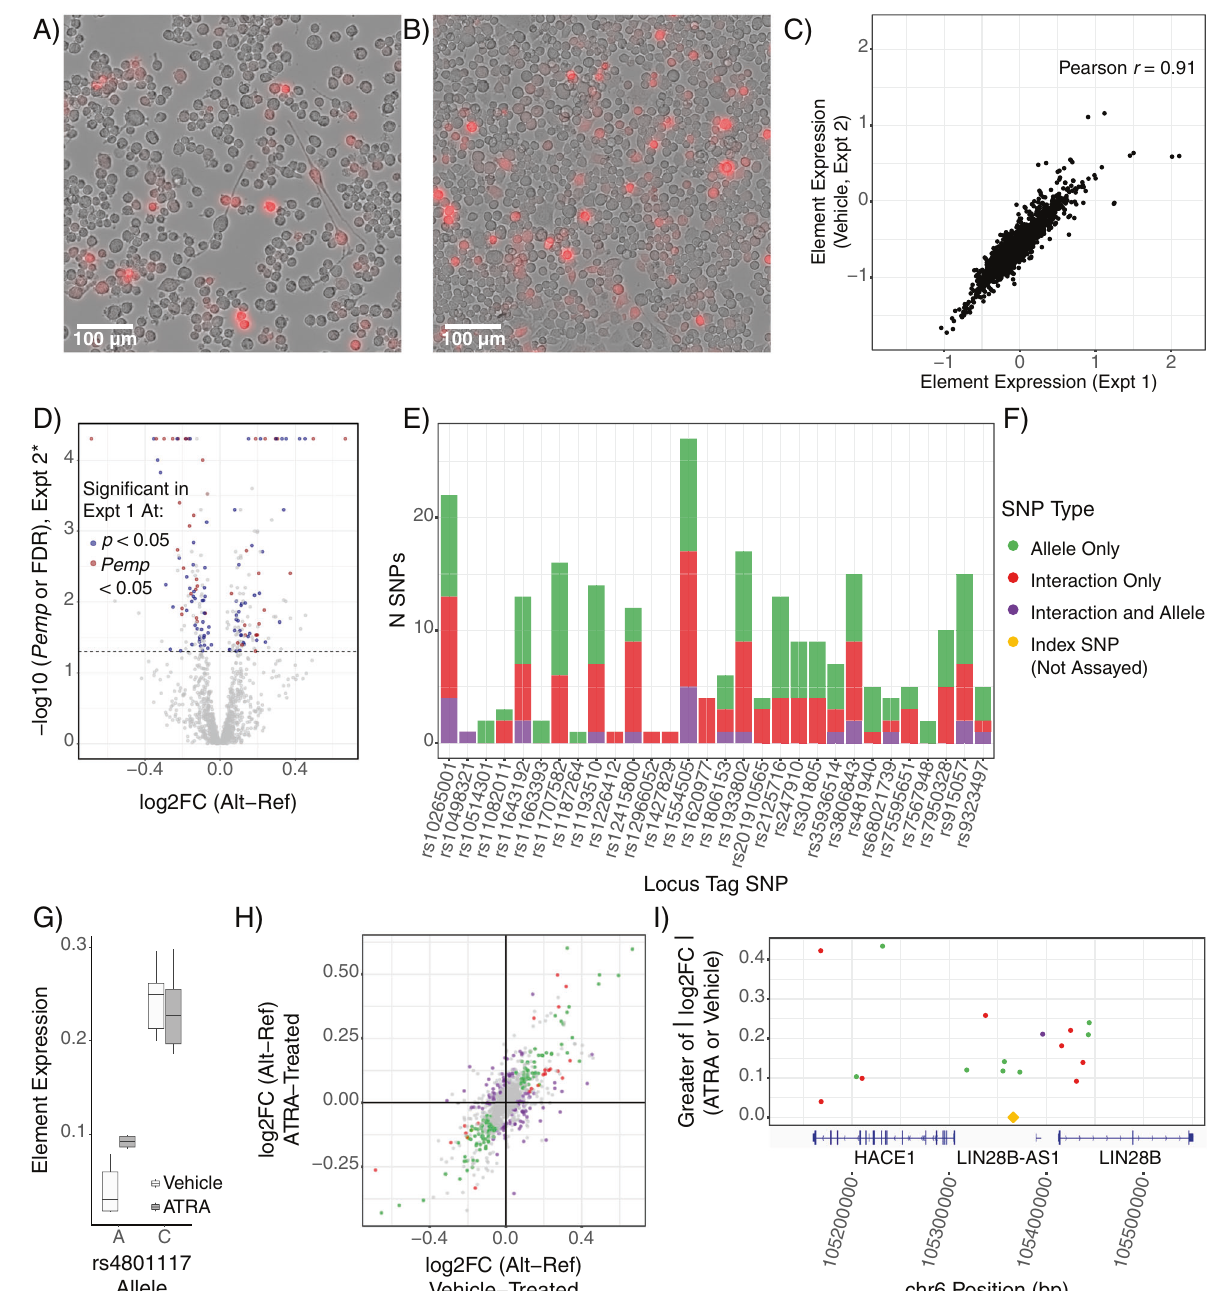
Fig. 4 Retinoid treatment alters transcriptional regulation and unmasks additional functional variants. A ATRA-treated cells show growth arrest and neurite growth, demonstrating effective ATRA treatment, while B vehicle-treated cells continued to proliferate in a de-differentiated state. C Results of the vehicle treatment replicate the initial MPRA fi ndings. Element (single-allele) expression values for each sequence assessed in both assays is plotted. D Signi fi cant and marginally signi fi cant functional SNPs from the fi rst assay showed effects in the second assay. The larger allelic difference value from the ATRA and vehicle single-condition analyses is plotted for each SNP on the x -axis; the y -axis value is the corresponding corrected p -value (FDR correction for the ATRA-only analysis or P emp for vehicle-only analysis). E Retinoids unmask functional SNPs with additional or exclusive retinoid-mediated effects. F SNP effect(s) color key for panels ( E ), ( H ), and ( I ). SNPs with both effects were those with LMM interaction Pemp < 0.05, LMM allele Pemp < 0.05, and both single-condition analyses showing the same allelic effect directionality at ATRA FDR < 0.1 AND vehicle P emp . G rs4801117-A shows greater activity with ATRA treatment while the C allele is unaffected. The ATRA having an expression effect only on the A allele is consistent with the A allele matching the RXRA motif as shown in Fig. 3B. H Transcriptional-regulatory SNPs show a wide range of altered and unaltered effects with ATRA treatment. Single-condition log2FC values are shown. I Several additional SNPs with retinoid-dependent function (i.e., allele-ATRA interaction) in the LIN28B locus. Only signi fi cant SNPs are illustrated. Notably, there are several functional SNPs clustered around the GWAS index SNP, suggesting association signal at this locus may be driven by multiple functional/conditionally functional